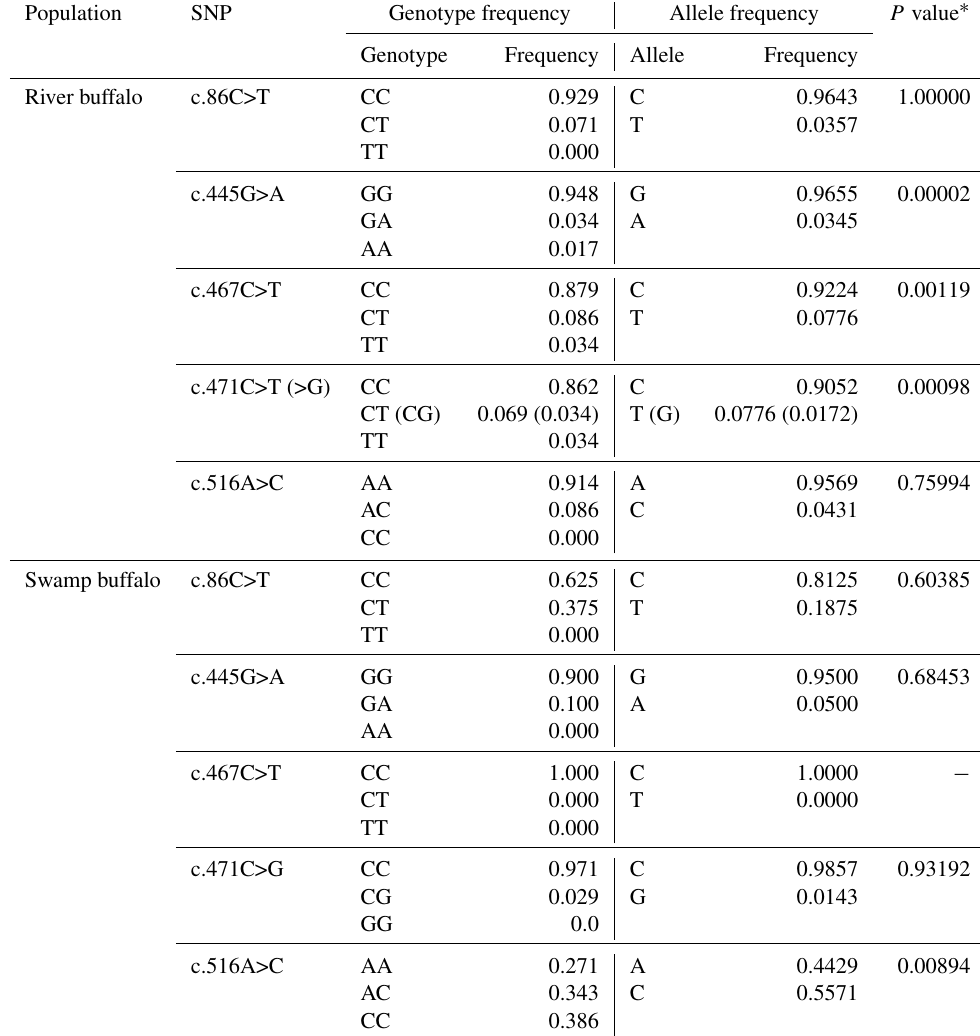
Table 3. Polymorphic loci and allelic and genotypic frequencies in two types of buffalo.